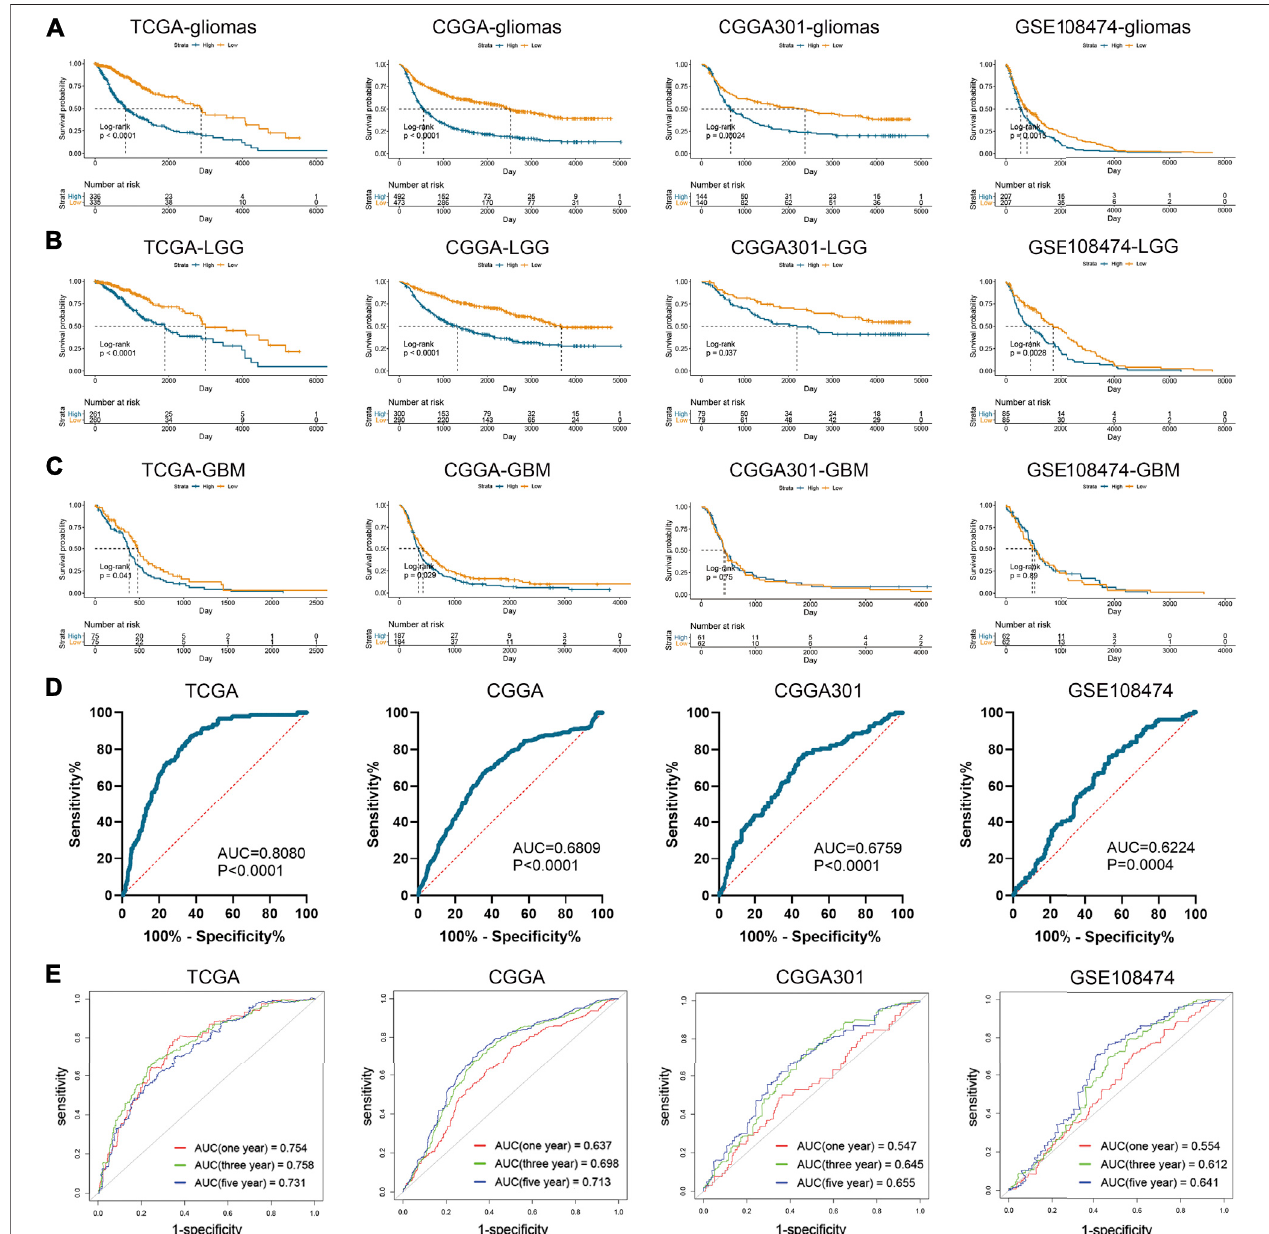
FIGURE8| PrognosticandpredictivevaluesofCD74ingliomas.A-C.Kaplan-MeieranalysisofCD74expressionintheoverallsurvivalofpatientswithgliomas (A) , lower-gradegliomas (B) ,andglioblastoma (C) .D.Patientsweredividedintoglioblastomaand lower-gradeglioma groups.ROCanalysiswasconducted toevaluatethe predictive accuracy of CD74 expression for the diagnosis of glioblastoma. E. ROC analysis of CD74 expression in predicting one-, three, and 5-year overall survival of glioma patients. ROC: receiver operating characteristic.